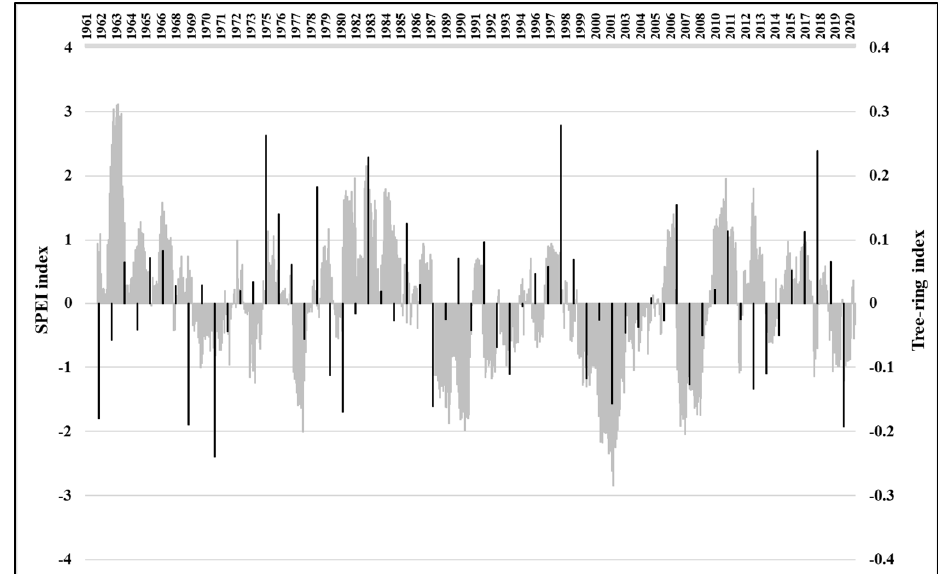
Figure 6. SPEI index for a 12-month period (gray columns), from 1961 to 2020 in Pertouli University Forest and the annual ring-width deviation index (black columns). Categorization of dryness by SPEI: Near normal (-1 to 1); Moderate dryness (-1.49 to -1); Severe dryness (-1.99 to -1.5); Extreme dryness (less than -2). The same ranges for positive values indicate wetness conditions.